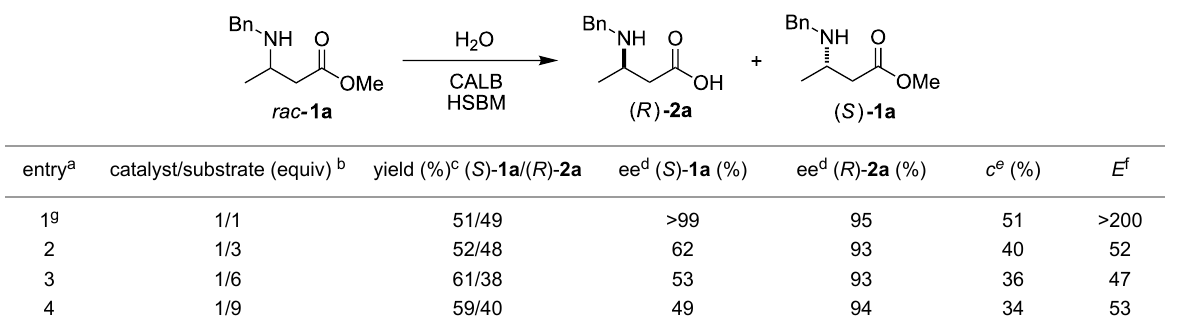
Table 4: Scaling-up of the enzymatic hydrolysis reaction under ball-milling using substrate rac - 1a .